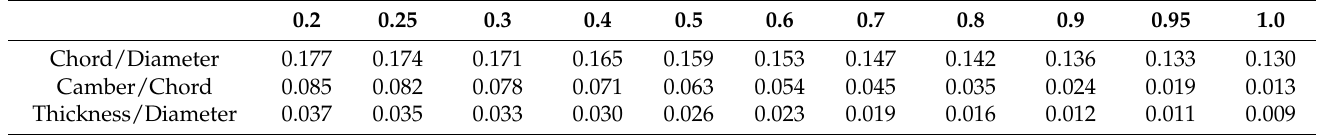
Table 5. Non-dimensionalized specifications of the initially designed